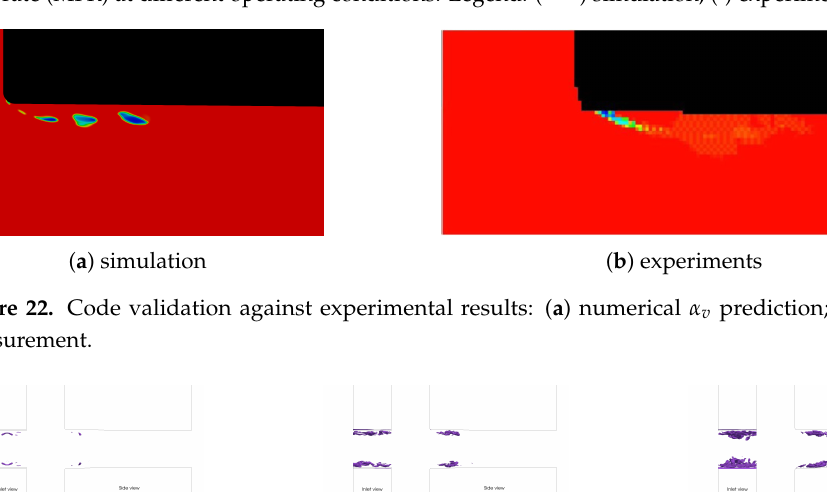
Figure 21. Velocity profiles at position 1 of Figure 19 for: ( a ) ∆ p = 55bar; ( b ) ∆ p = 60bar. ( c ) Mass flow rate (MFR) at different operating conditions. Legend: ( ) simulation; ( ) experiments.